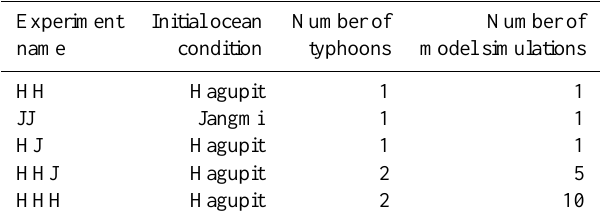
Table 1. Description of the numerical experiments. Experiment